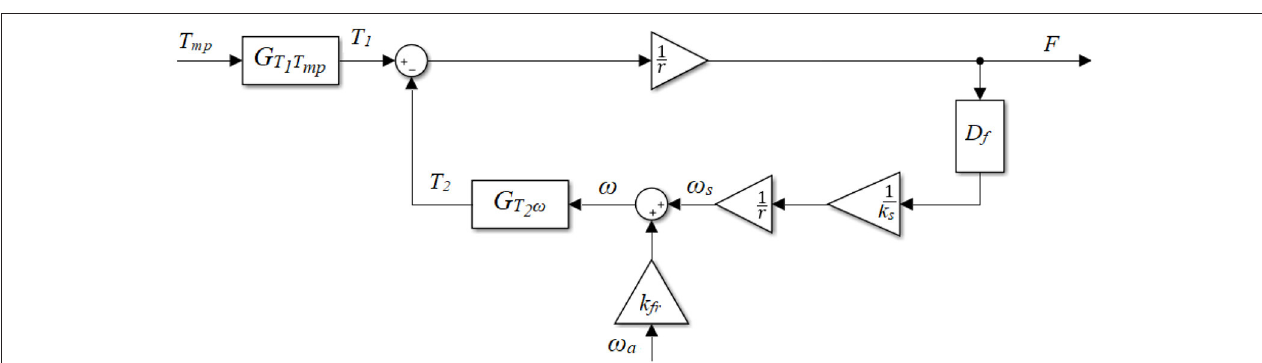
FIGURE 2 | Block diagram of the active cable-driven robotic system.